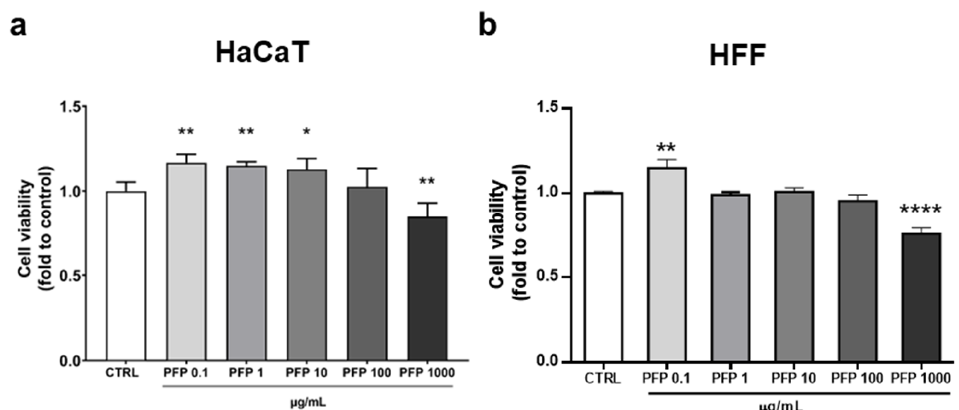
Figure 3. Cell viability analysis by CCK-8 assay on HaCaT ( a ) and HFF ( b ) cells treated with PFP at the concentrations of 0.1, 1, 10, 100 and 1000 µg/mL for 24 h. Each column represents mean ± SD. Data were analyzed by one-way analysis of variance followed by Tukey: * p < 0.05, ** p < 0.01, **** p < 0.0001 vs. CTRL.